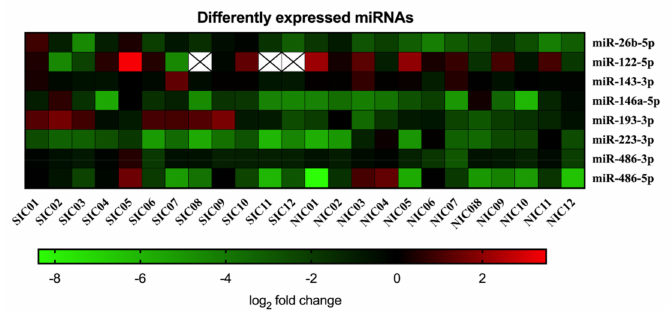
Figure 4. Serum copy counts of miRNAs miR-26b-5p, miR-122-5p, miR-143-3p, miR-146a-5p, miR-193-3p, miR-223-3p, miR-486-3p, and miR-486-5p were determined in septic intensive care patients (SIC) and non-septic intensive care patients (NIC) by means of the Droplet Digital PCR technology. Data are presentedforeachindividualpatientaslog 2